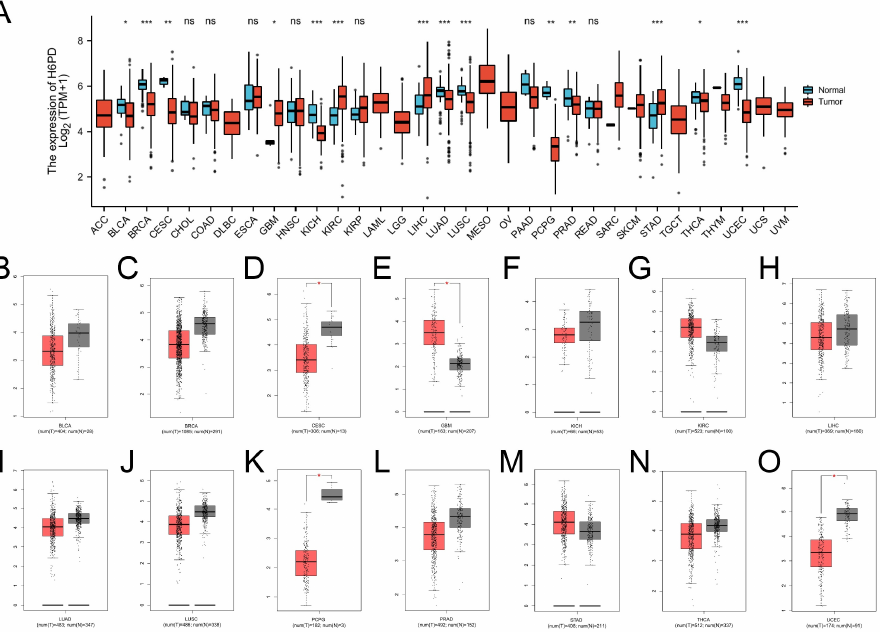
Figure 1. Expression analysis for H6PD in pan-cancer types . ( A ) The expression of H6PD in pan-cancer types of human cancer based on TCGA cancer and normal data. Differences in H6PD were detected in 14 cancers: bladder cancer (BLCA), breast cancer (BRCA), cervical squamous cell carcinoma (CESC), glioblastoma (GBM), kidney chromosome cancer (KICH), kidney renal clear cell carcinoma (KIRC), liver hepatocellular carcinoma (LIHC), lung adenocarcinoma (LUAD), lung squamous cell carcinoma(LUSC), pheochromocytoma and paraganglioma (PCPG), prostate ade- nocarcinoma (PRAD), stomach adenocarcinoma (STAD), thyroid cancer (THCA), and uterine cor- pus endometrial carcinoma (UCEC). ( B – O ) H6PD expression in 14 cancers was provided com- pared to corresponding TCGA and GTEx normal tissues. Differences in H6PD were detected in four cancers: CESC, GBM, PCPG, and UCEC. Briefly, H6PD was upregulated in GBM and down- regulated in CESC, PCPG, and UCEC, suggesting that H6PD may play an oncogenic role in these four cancers. (* p -value < 0.05; ** p -value < 0.01; *** p value < 0.001).